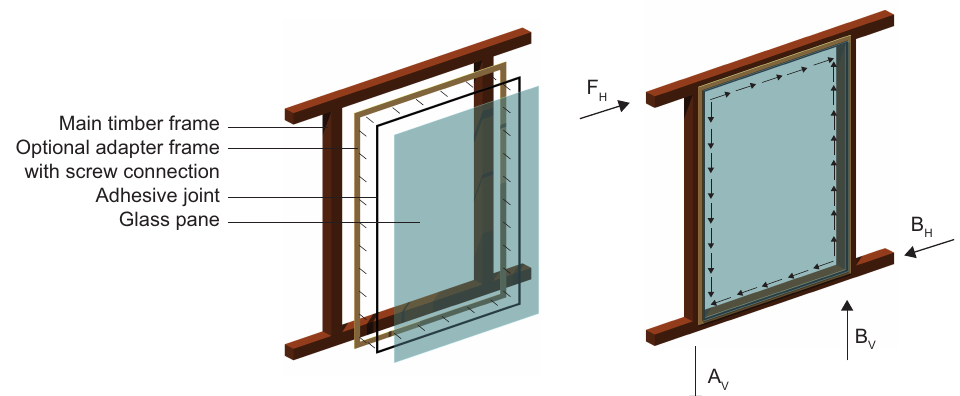
Fig. 1 General build-up and load-bearing principle of a timber-glass shear wall element according to Edl